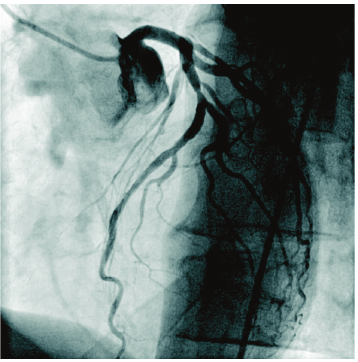
Figure 5: Resolution of spasm following intracoronary nitroglycer- ine (LAO 35, cranial 18).